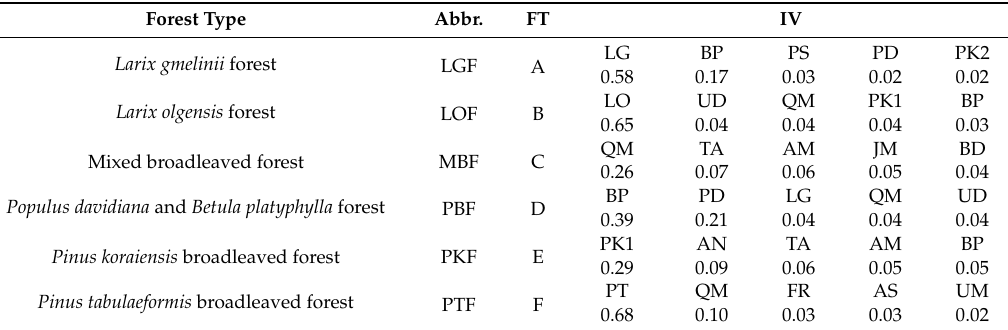
Figure 2. Ward ′ s minimum variance clustering. Among the six forest types, Larix gmelinii forest (LGF) and Larix olgensis forest (LOF) are coniferous forest; mixed broadleaved forest (MBF) and Populus davidiana and Betula platyphylla forest (PBF) are broadleaved forest and mixed broadleaved forest (MBF) developed earlier; Pinus koraiensis -broadleaved forest (PKF) and Pinus tabulaeformis -broadleaved forest (PTF) are theropencedrymion forest. Table 1. Mean IV of top five trees.